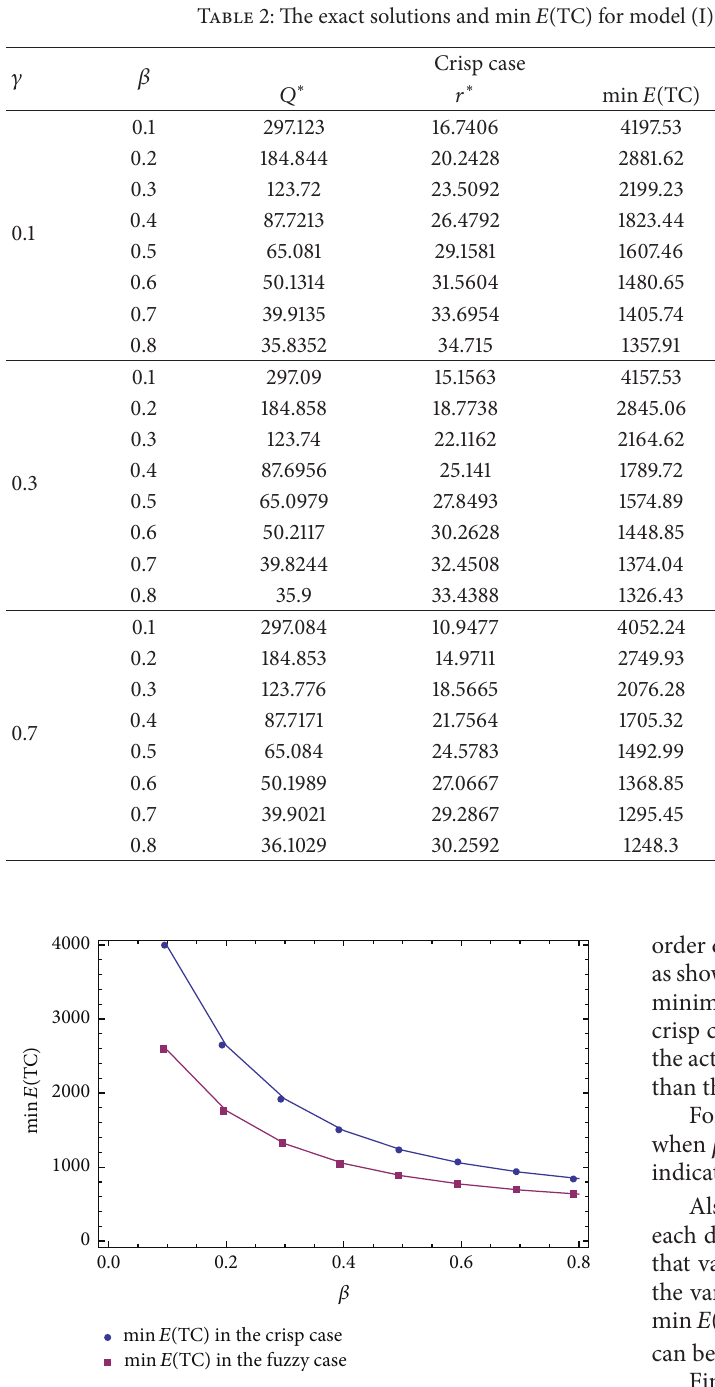
Table 2: The exact solutions and min 𝐸 (TC) for model (I) and model ( I f ) at Laplace distribution.